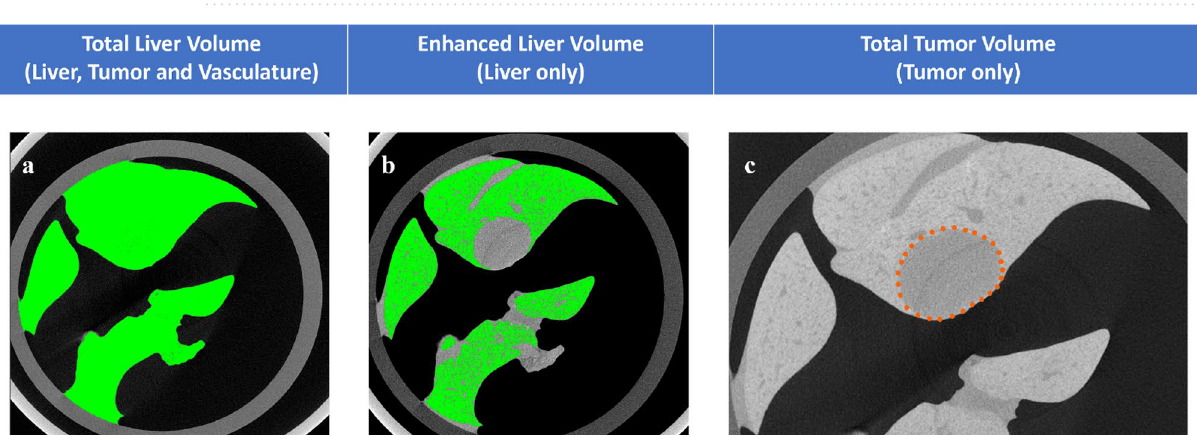
Figure 4. Volume measurements of liver, liver vasculature and tumor from mouse 2. The Total liver volume measured the entire volume of the liver including the liver vasculature and tumor ( a ). The enhanced liver parenchyma only has the volume of the liver without the liver vasculature or tumors ( b ). The manually obtained total tumor volume only has the volume of the tumor from the liver of mouse 2 ( c